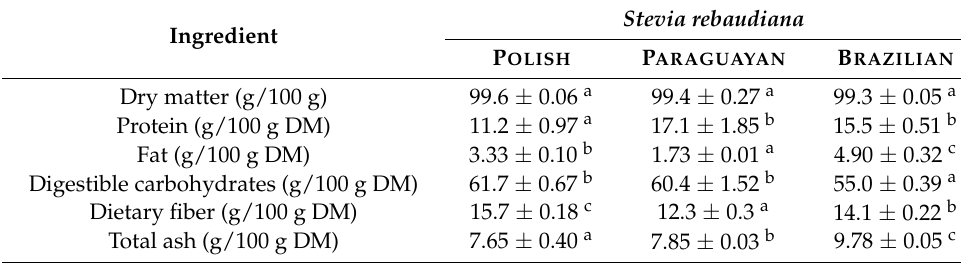
Table 1. Proximate composition of Stevia rebaudiana Bertoni dried leaves depending on the country of origin.